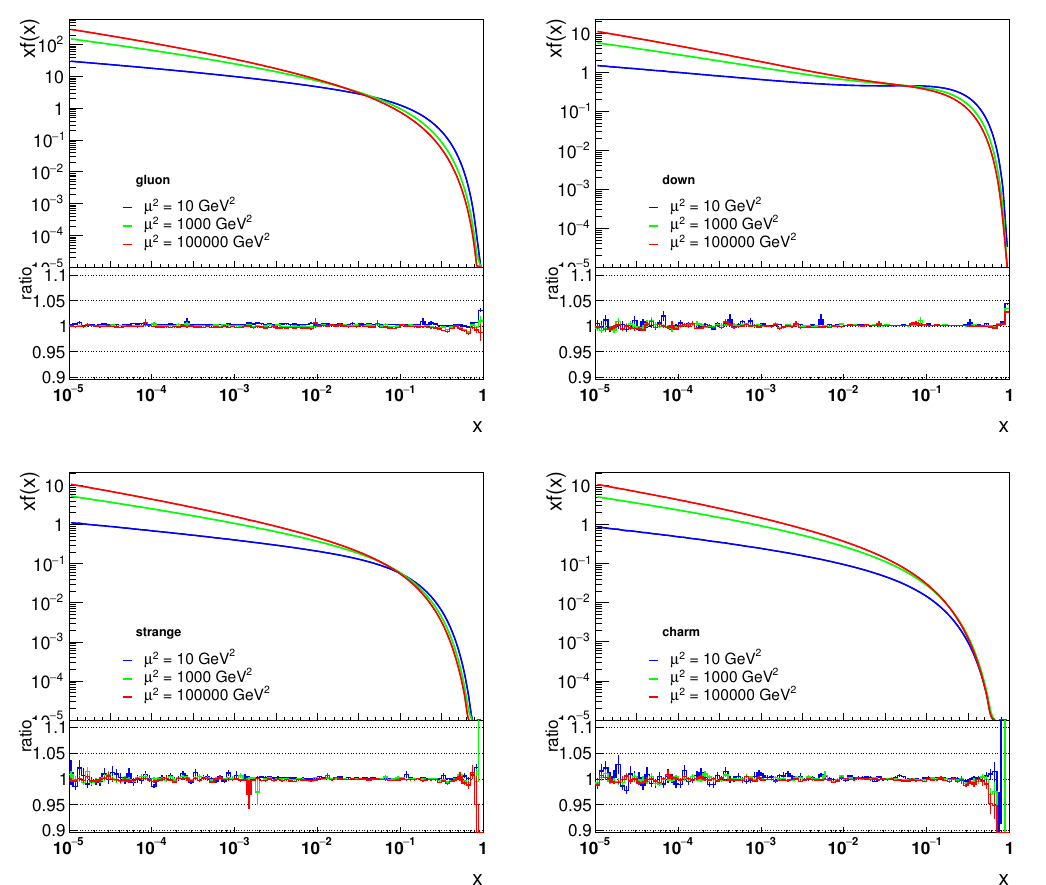
Figure 3 . The transverse momentum integrated (iTMD) parton densities obtained from the parton branching solution, compared with the prediction from Qcdnum . The densities are evolved up to di(cid:11)erent scales (cid:22) 2 using splitting kernels at NLO. The ratio plots show the ratio of the curves obtained with the parton branching method divided by the prediction from Qcdnum